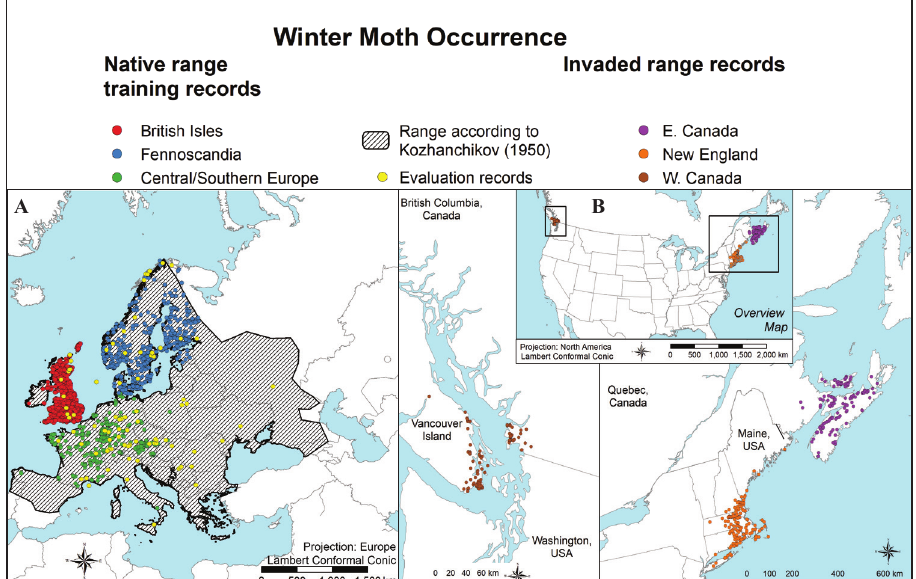
Figure 1. A map showing the distribution of the native range for winter moth (Operophtera brumata), recreated from Kozhanchikov (1950), as well as native winter moth occurrence records used as training records – colored according to three geographic filters (British Isles in red, Fennoscandia in blue and Central/Southern Europe in green) and evaluation records shown in yellow B map of North American records reflecting the invaded range separated into three geographic regions (western Canada in brown, New England in orange and eastern Canada in